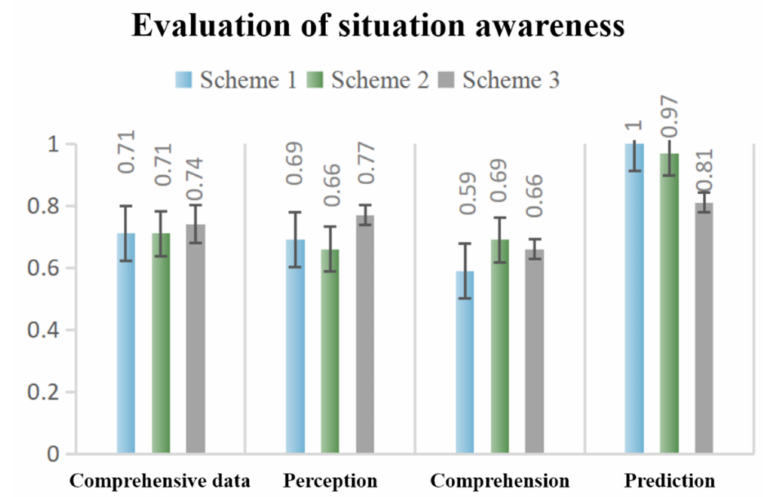
Figure 8. Situation awareness assessment results.